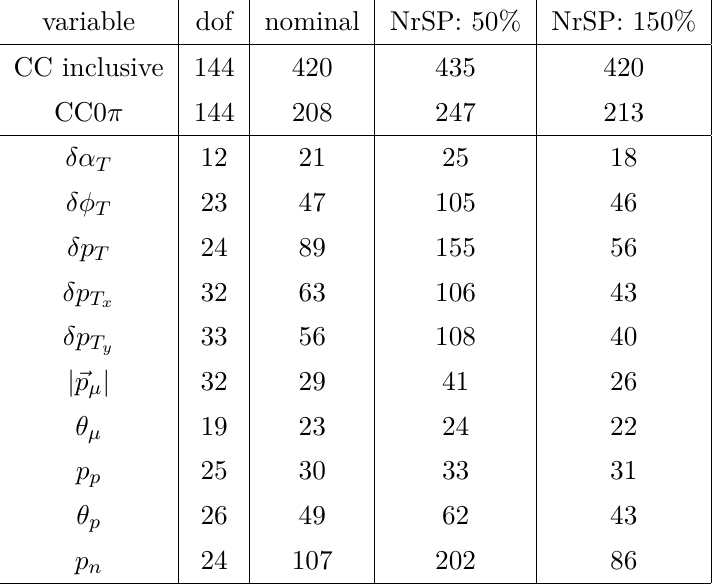
Table 4 . Same as in table 3, but for MINERvA experiment.